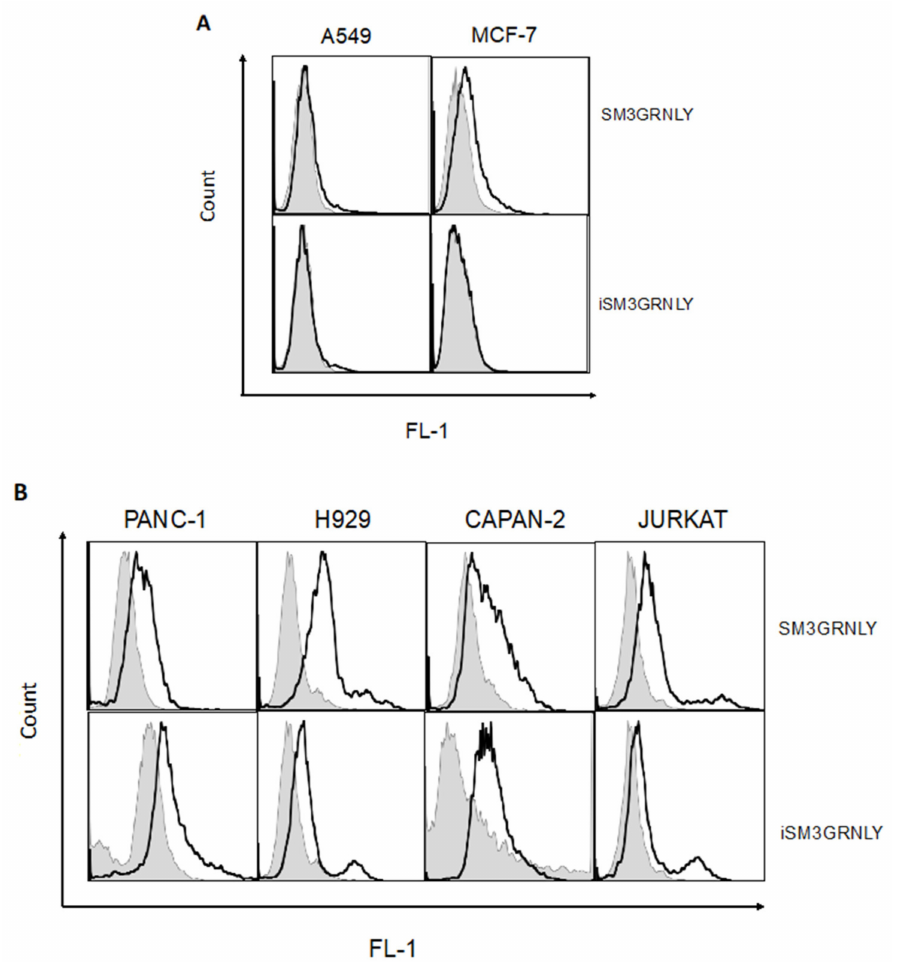
Figure 5. SM3GRNLY and iSM3GRNLY binding to the Tn antigen expressed on the cell surface. ( A ). MCF7 (left panels) and A549 (right panels) were stained with SM3GRNLY (upper panels) or iSM3GRNLY (lower panels), as indicated in Materials and Methods, and labellings analyzed by flow cytometry. Panc-1, Capan-2, NCI-H929 and Jurkat cells were stained with SM3GRNLY or with iSM3GRNLY ( B ), as indicated. Black histograms correspond to the fluorescence of the specific labellings and gray histograms to that of the negative